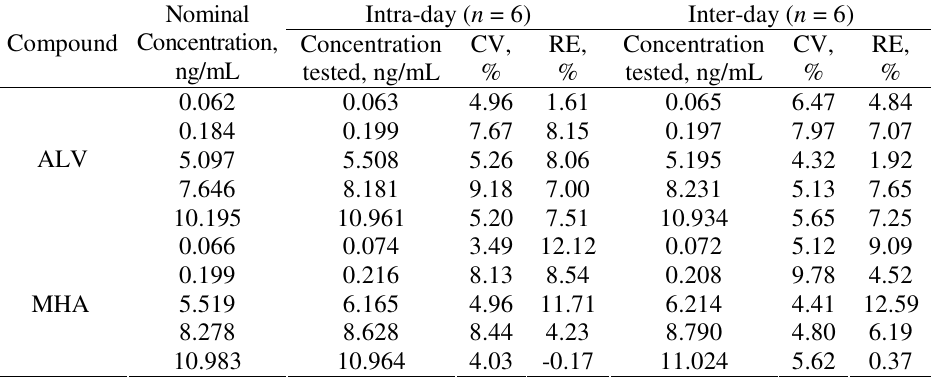
Table 1. Results from assessment of the accuracy and precision of the method Intra-day ( n = 6)